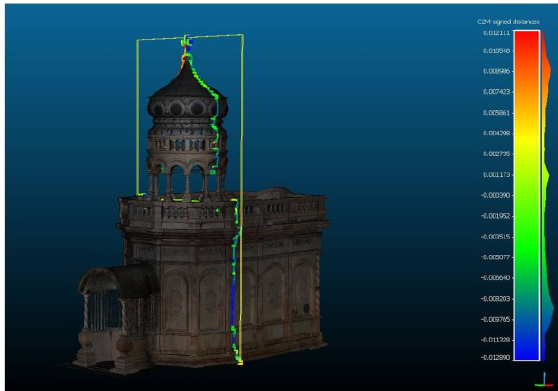
Figure 12 : The 1 st vertical section and its deviations from the 3D model’s